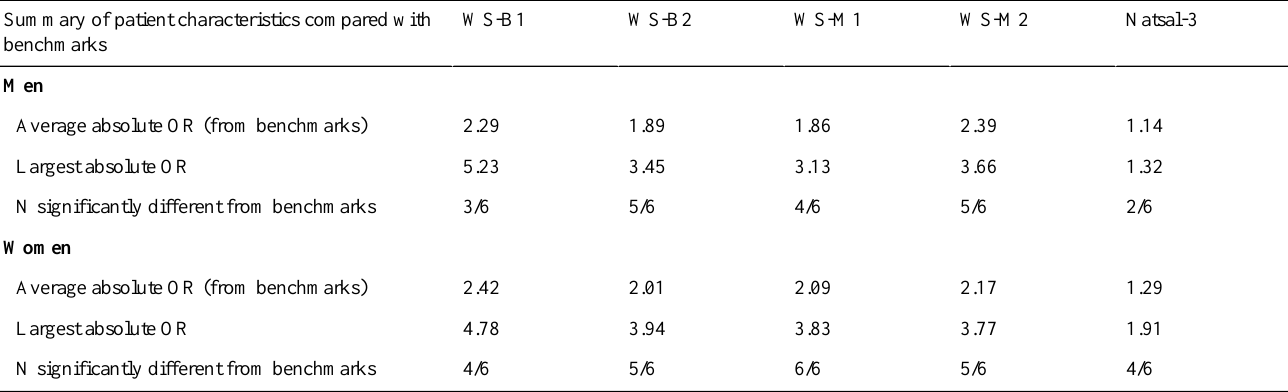
Table 2. Summary of participant characteristics for men and women: Web survey basic quota 1 and 2 (WS-B1 and WS-B2), Web survey modified quota 1 and 2 (WS-M1 and WS-M2), and Natsal-3 compared with independent benchmarks.